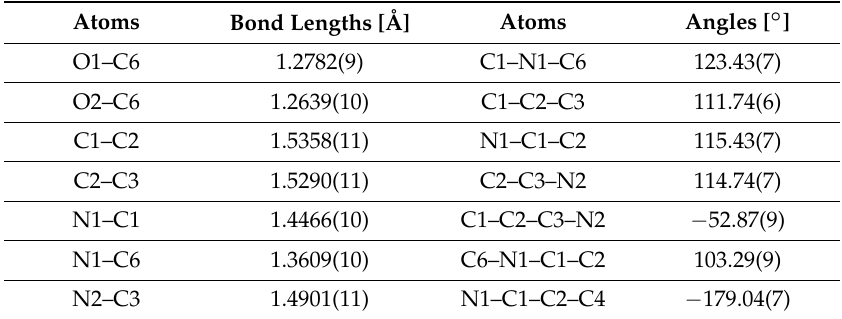
Table 1. Selected geometric parameters of the title compound (bond lengths [Å]; angles [ ◦